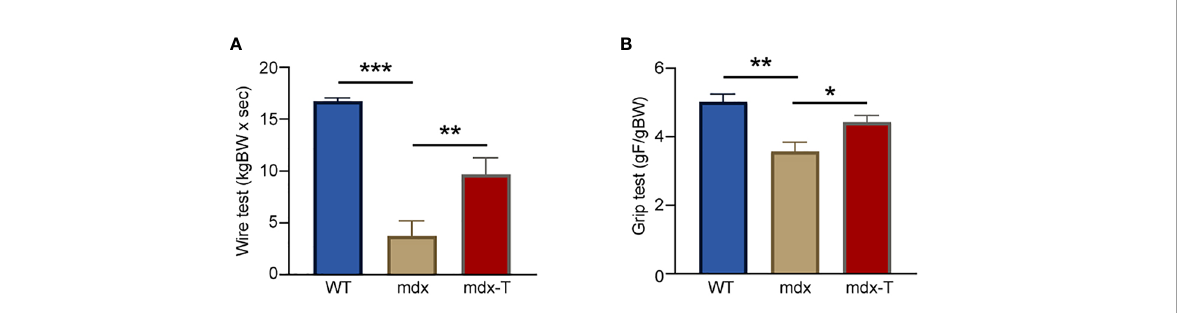
FIGURE 1 MCC950 treatment improves global force and resistance of mdx mice. Three groups of mice were compared at the age of 11 weeks: WT, mdx (untreated) and mdx-T (mdx treated with MCC950) mice. Functional tests were carried out in vivo . (A) Mice were subjected to a wire test where they were suspended by their limbs and the time until they completely released the wire and fell was registered (seconds). This time was then normalized to body weight (kgBW x sec). (B) Mice were lowered on a grid connected to a sensor to measure the muscle force of their forelimbs; data were then expressed in gram-force relative to gram-body weight (gF/gBW). Data are means ± SEM; n = 6 mice per group for all experiments. Statistical analysis was performed using one-way ANOVA followed by Tukey ’ s test. * P < 0.05, ** P < 0.01, *** P <